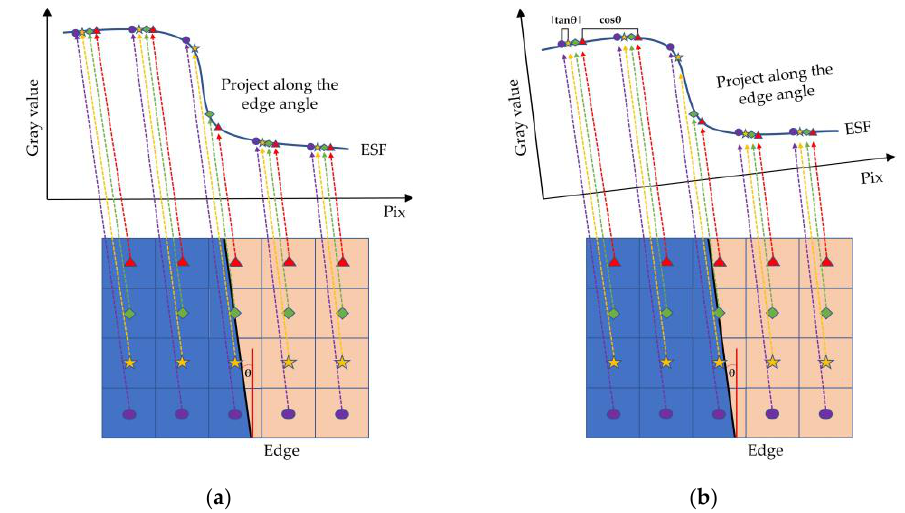
Figure 6. Projection Diagram. ( a ) Projection Diagram of ISO 12233, Hough, LSD, and Algorithm in this paper. ( b ) Projection Diagram of OMNI-sine. this paper. ( b ) Projection Diagram of